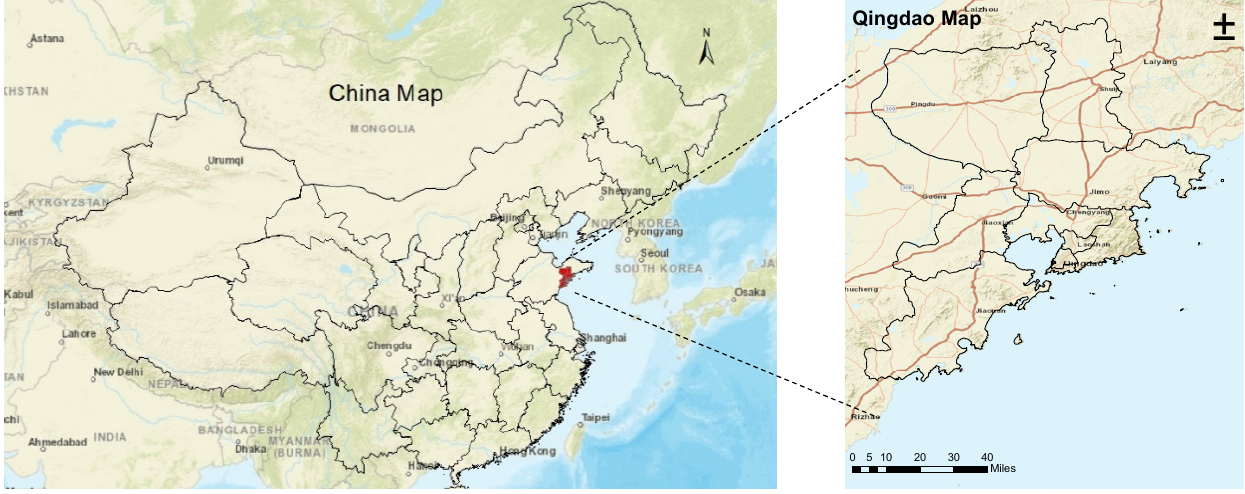
Figure 1. The maps of China and Qingdao.